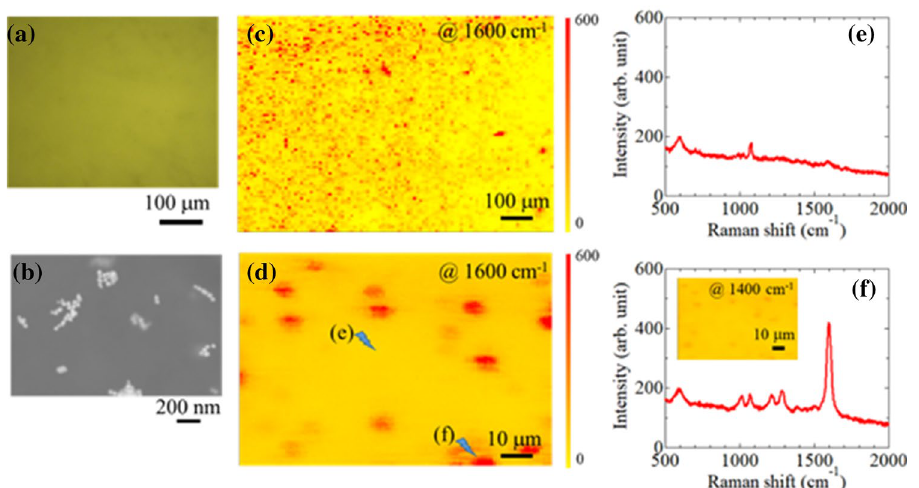
Figure 5. Distribution of the nanobeacons: ( a ) Optical photograph of the paper surface to which we applied aqueous ink that included nanobeacons. ( b ) Scanning electron microscopy image of Au nanoparticle aggregates included in the stealth nanobeacon. Surface-enhanced Raman spectroscopy (SERS) mappings of ( c ) 1 mm × 1 mm and ( d ) 100 μm × 100 μm at 1600 cm −1 . ( e , f ) SERS spectra for the locations in the Raman mapping shown in ( d ). The inset in ( f ) shows a SERS mapping at ( d ) at 1400 cm −1